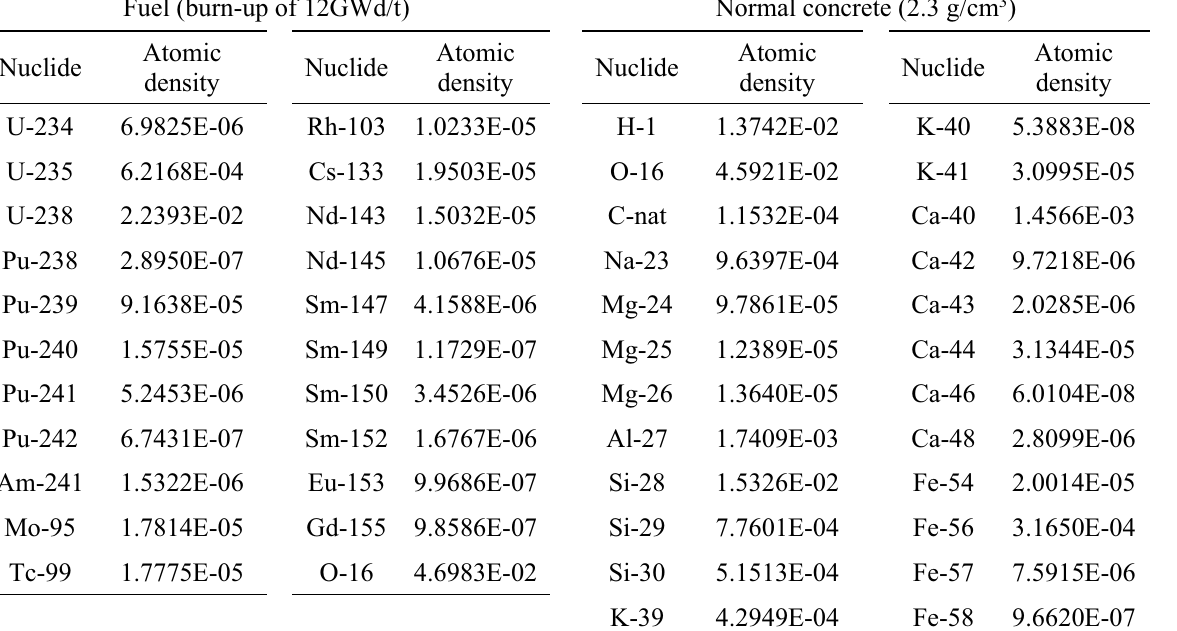
Table I. Atomic densities (10 24 atoms/cm 3 ) of fuel and concrete